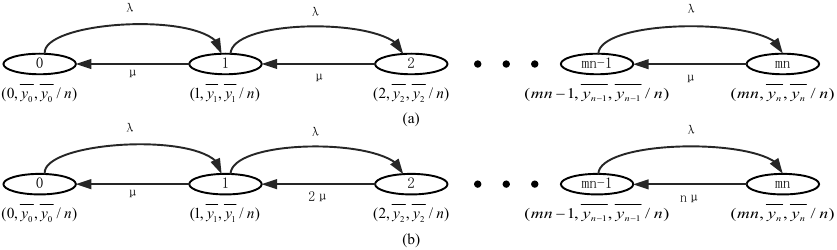
Figure 7. State transition diagrams of coexisting WBANs under m-tolerated channel conflict model. ( a ) Service-dependent analysis model; ( b ) Service-independent analysis model.